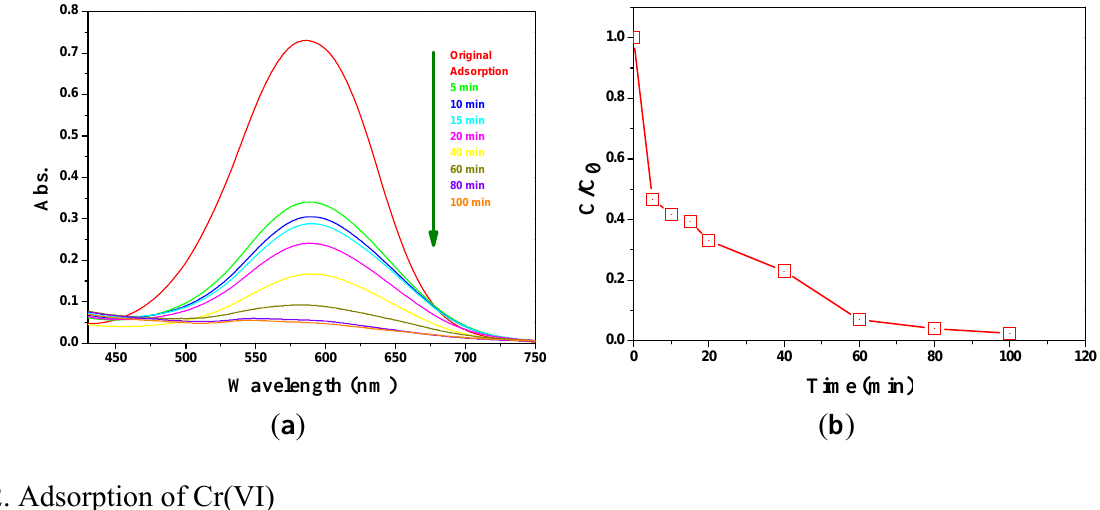
Figure 5. The temporal evolution of UV spectral of methyl blue solution at the presence of PVI-TFSI ( a ) and the dependence of concentration of methyl blue on absorption time ( b